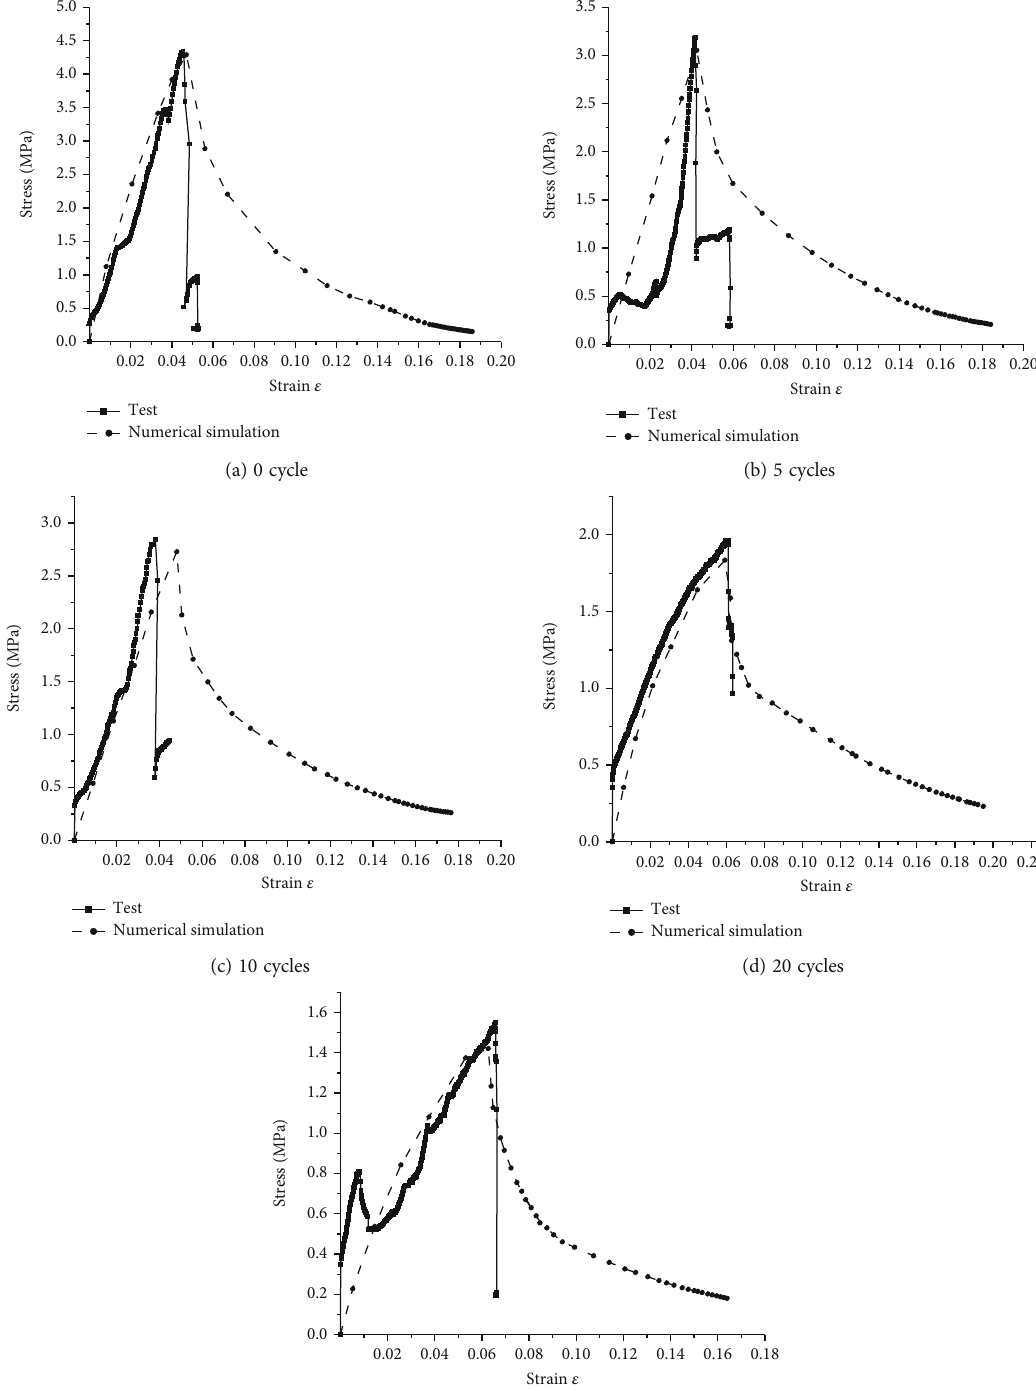
Figure 7: Comparison of stress-strain curves of the numerical simulation of sandstone and test